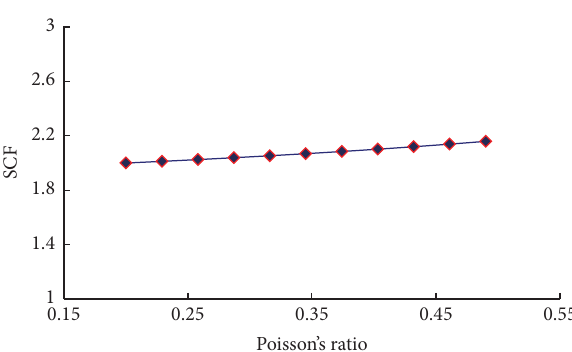
Figure 4: The relationship between the stress concentration factor and Poisson’s ratio.